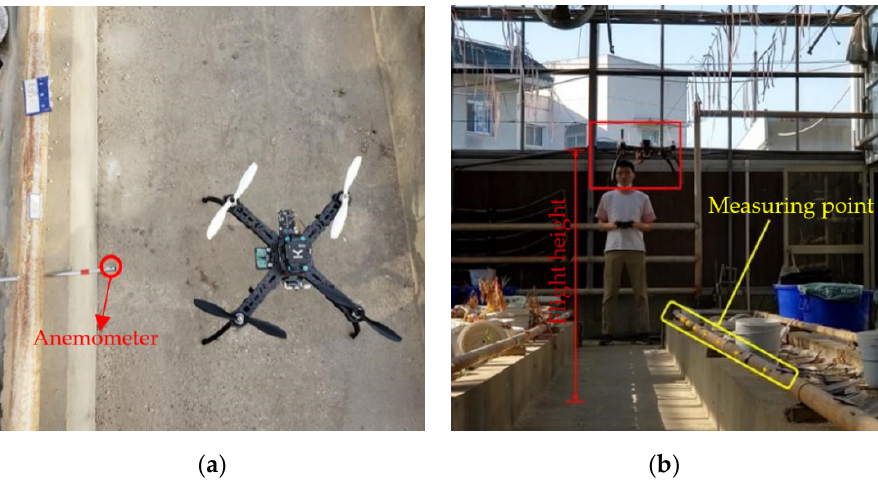
Figure 12. Greenhouse test. ( a ) Anemometer and UAV; ( b ) UAV flight in